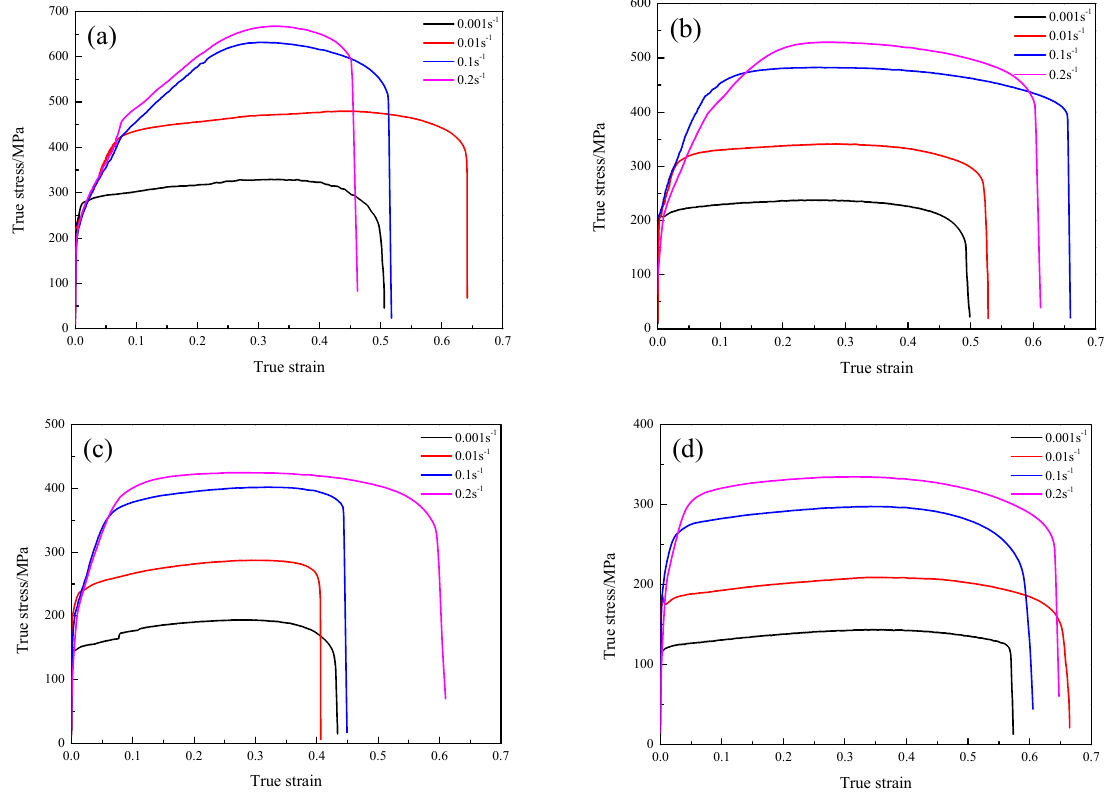
Figure 3. The true stress − true strain curves of the GH3230 superalloy double-sheet during tensile deformation under different temperatures: ( a ) 1123 K; ( b ) 1173 K; ( c ) 1223 K; ( d ) 1273 K.